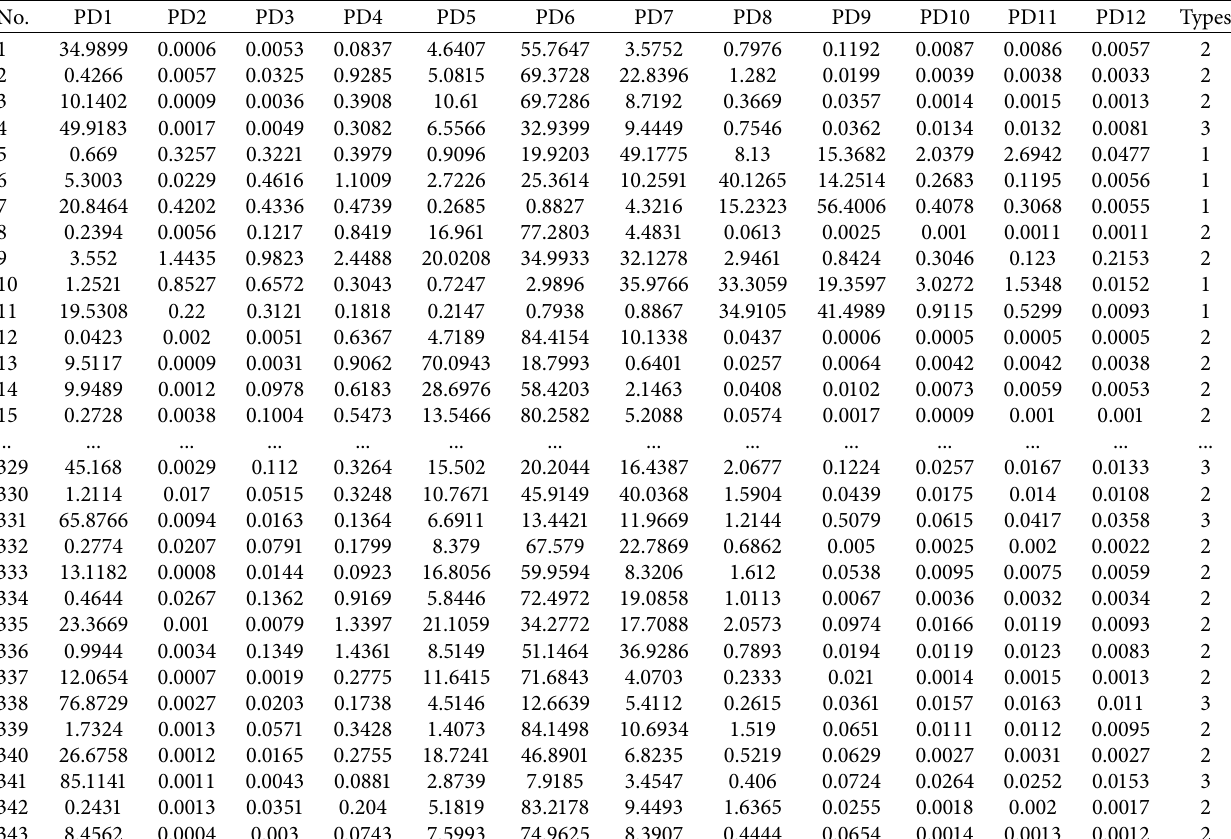
Table 10: Samples of SVM classification models.